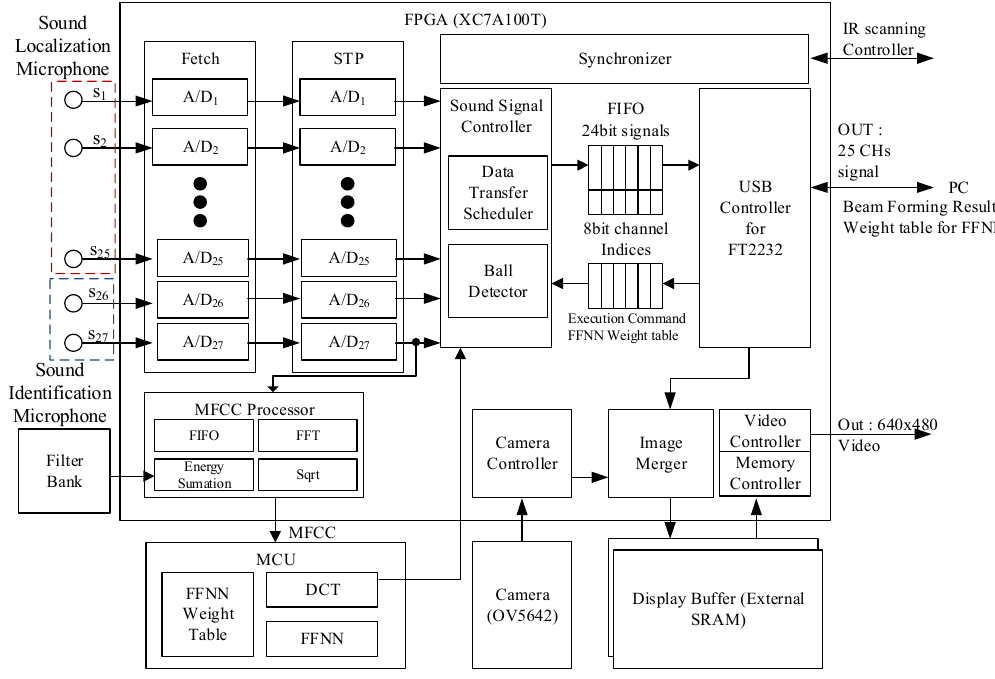
Figure 6. Overall system implementation for the estimation of 3D ball motion.